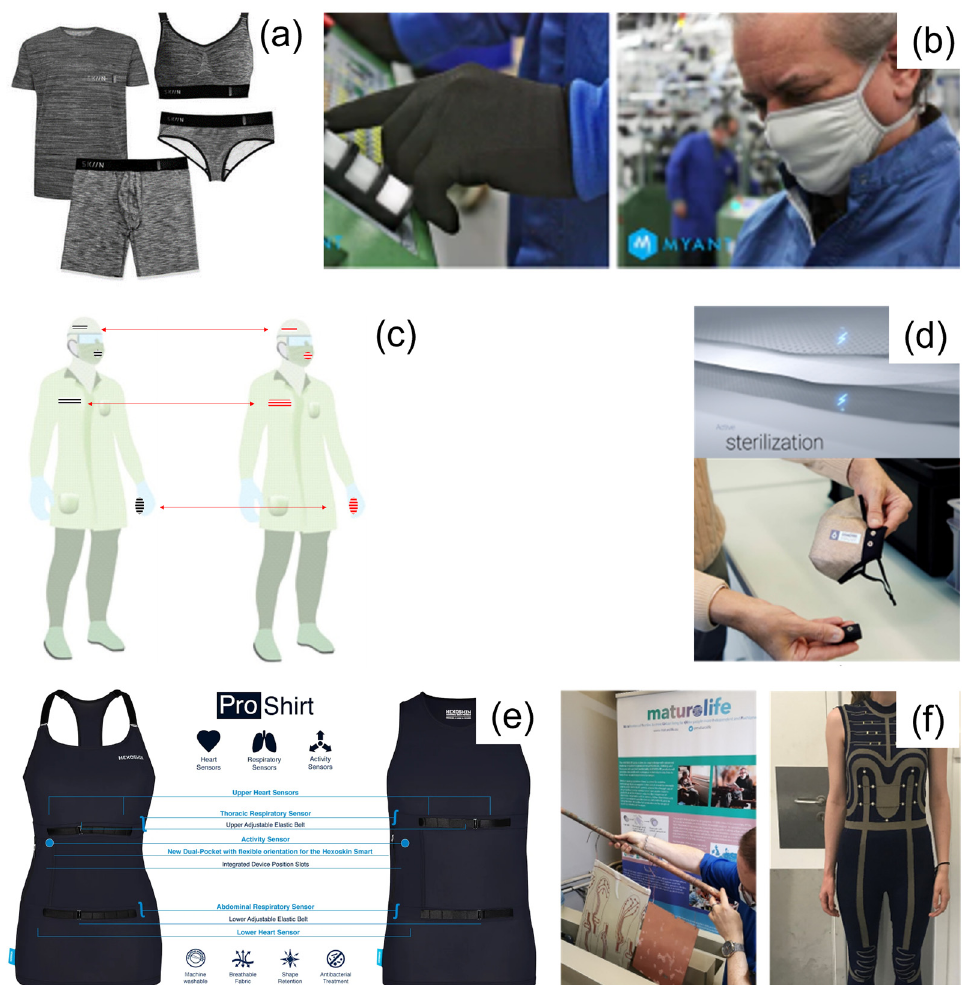
Figure 5. Skiin biosensing garment by Myant ( a ) [194]; Myant gloves and masks ( b ) [195] (reproduced with permission from Myant); sensor-integrated protective wearables for the early detection of SARS-CoV-2 before (left) and after contamination (right) ( c ) [196]; Osmotex sterilizer: structure [197] (top), mask prototype [189] (bottom) ( d ) (reproduced with permission from Osmotex); Hexoskin proshirts ( e ) [198] (reproduced with permission from Hexoskin); and Maturolife project shoe sole prototyping for walking pattern (left) and E-Fashion 2 project movement sensor prototyping (right) ( f ) [199] (reproduced with permission from IFTH).